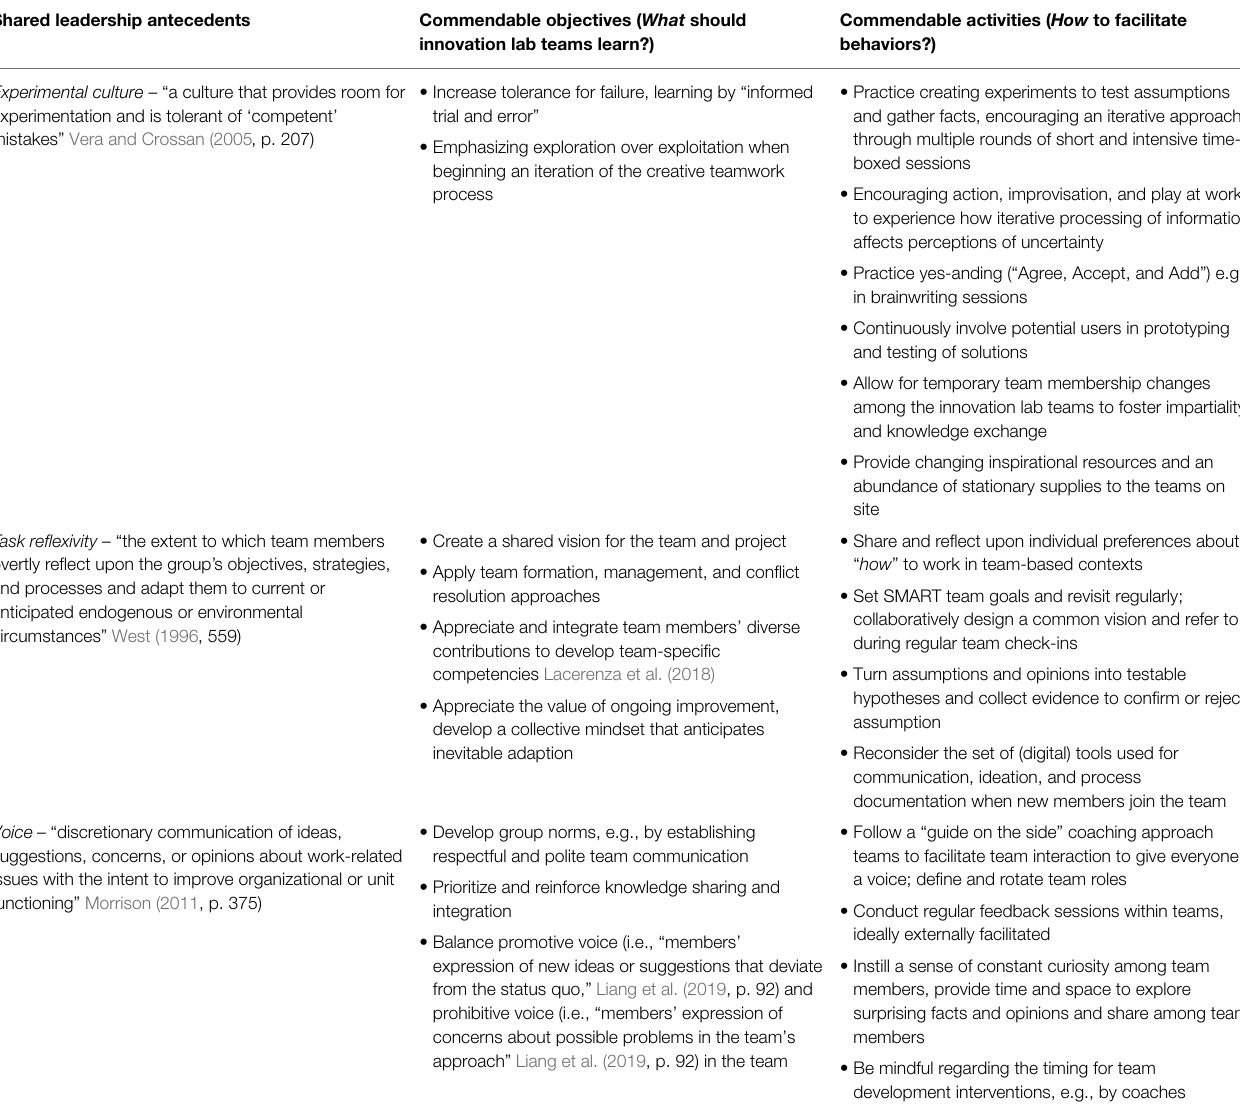
TABLE 6 | Objectives and activities for shared leadership